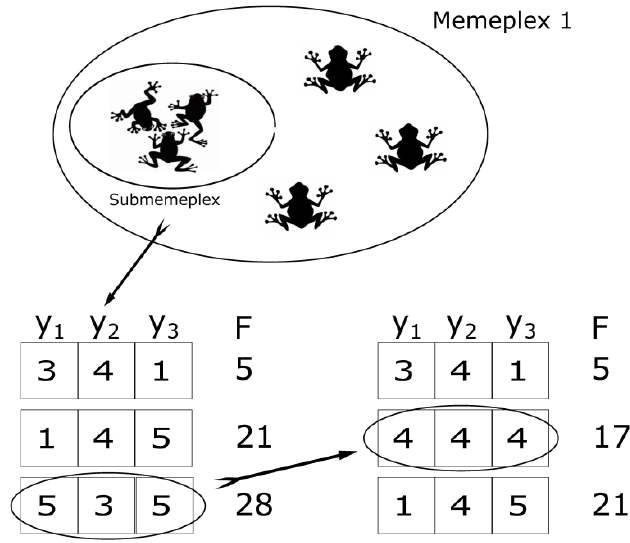
Figure 3. Memetic evolution during an evolutionary step N s .